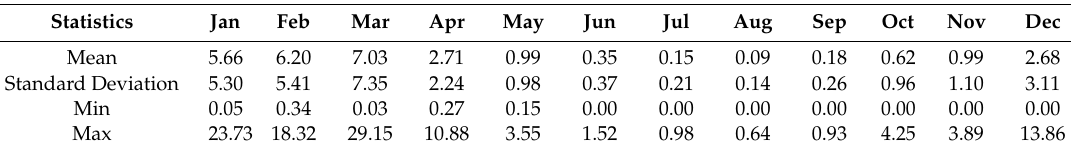
Table 7. Statistics on the monthly streamflow observed at the Alcantara at Moio during the period 1981–2000.